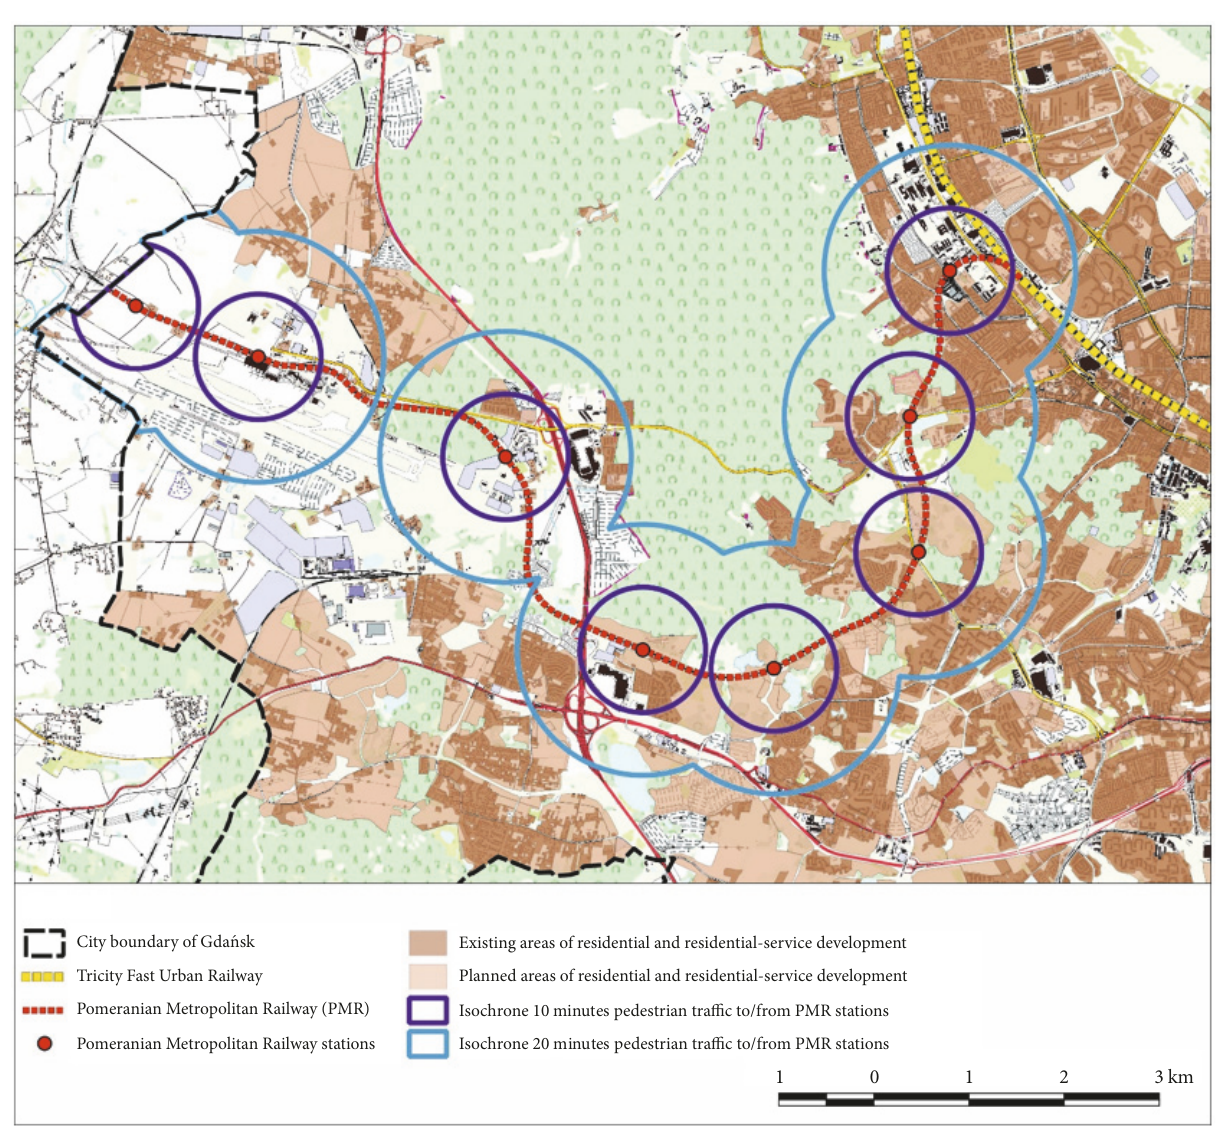
Figure 7: Directions and perspectives for development of different land use forms in the area of 10 and 20 min walking access to the PMR